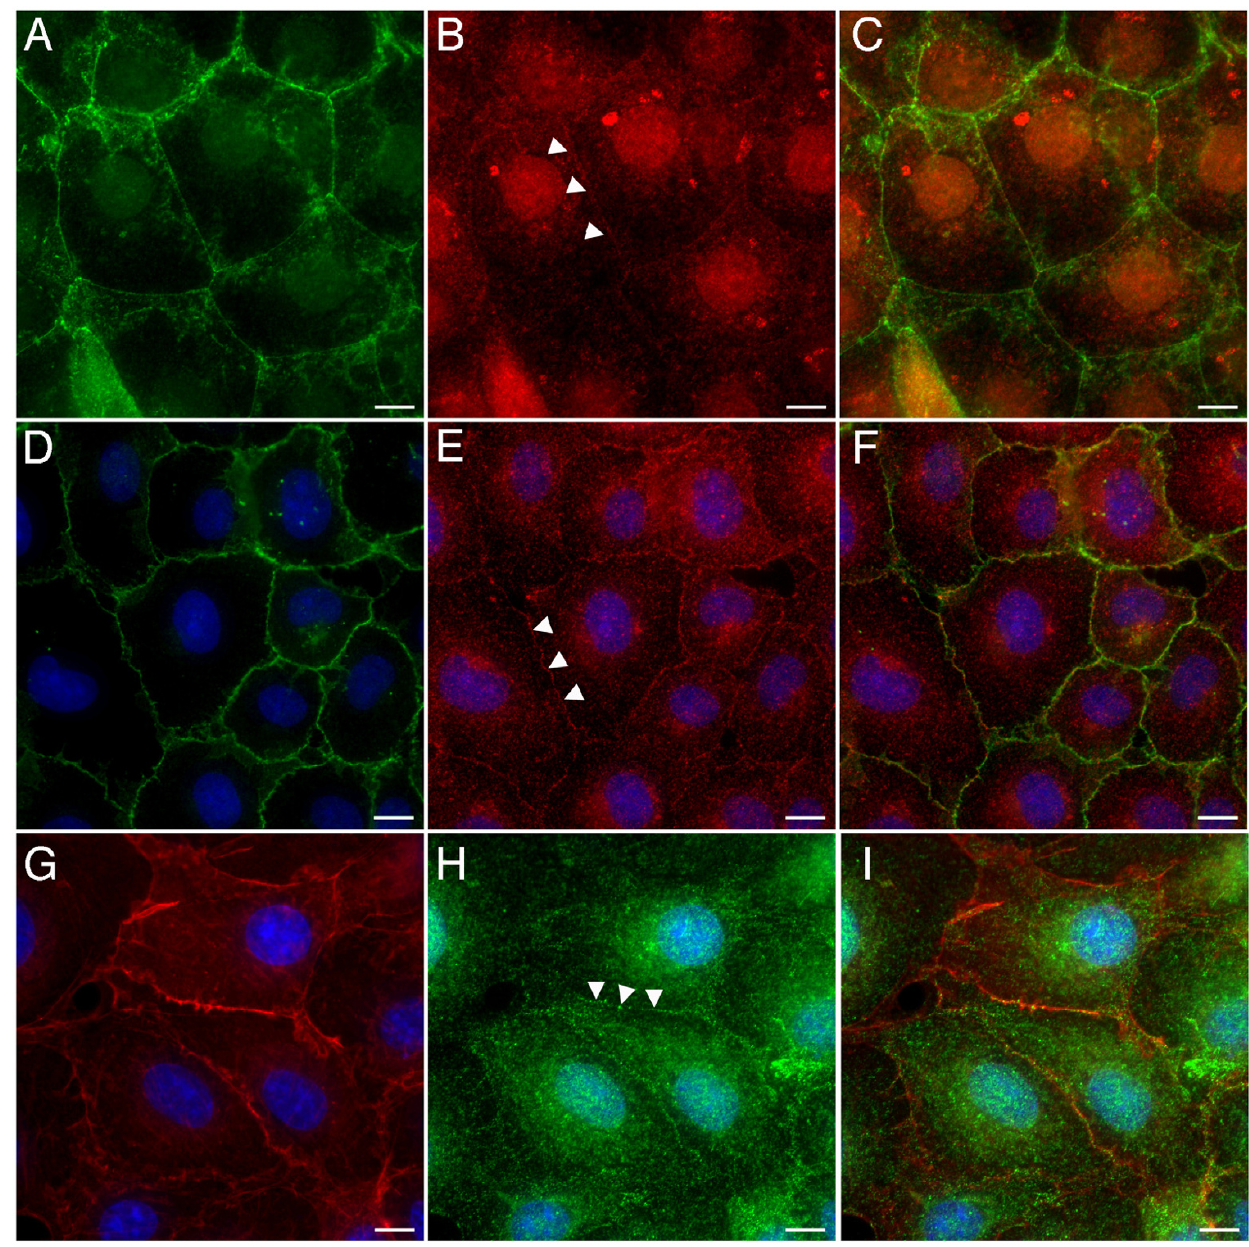
Figure 3 Junction formation and APC localisation in COS-7 cells . Panels A-C. COS-7 cells contain cadherins and endogenous APC (arrowheads) at sites of cell-cell contact, Cadherin green and APC red, panel C is a merged image. Panels D-F. COS-7 cells also have the junctional protein β -catenin localised along with endogenous APC (arrowheads) at adhesive membranes. β - catenin green, APC red and DAPI blue, panel F is a merged image. Panels G-I. Cortical actin and APC (arrowheads) are associ- ated with sites of cell-cell contact in COS-7 cells. Actin red, APC green and DAPI blue, Panel I is a merged image. Bars = 10 µ